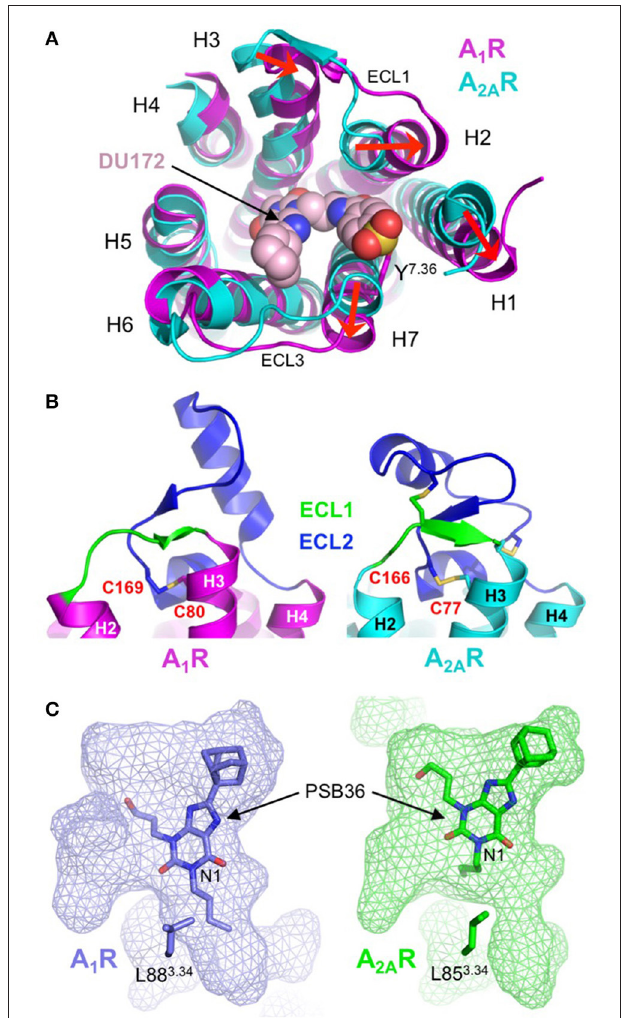
FIGURE 6 | Structural diversity of the adenosine receptor family. (A) Extracellular view of the conformational differences between DU172-bound A 1 R (colored magenta; PDB: 5UEN) (Glukhova et al., 2017) and ZM241385-bound A 2A R (colored cyan; PDB: 4EIY) (Liu et al., 2012). The extracellular ends of H1, H2 and H7 are displaced outwards by 5, 4, and 4 Å, respectively and H3 is displaced inwards by 4 Å (indicated by red arrows). The antagonist DU172 (shown as spheres) is covalently attached to Y271 7.36 (shown as sticks) through a benzene sulfonate linkage. Note that for clarity, ECL2 has been omitted from the alignment. (B) Differential conformations of ECL1 (colored green) and ECL2 (colored blue) in A 1 R (colored magenta; PDB: 5UEN) (Glukhova et al., 2017) and A 2A R (colored cyan; PDB: 4EIY) (Liu et al., 2012), disulphide bonds are shown as sticks. In A 1 R ECL2 adopts an extended conformation that is stabilized by a single disulphide bond (C80 3.25 -C169 ECL2 ). In contrast, ECL2 from A 2A R adopts a compact conformation that is stabilized by three disulphide bond, one of which (C77 3.25 -C166 ECL2 ) is conserved in A 1 R. (C) Surface representation of the ligand-binding pocket (rendered as semi-transparent mesh) in A 1 R (colored blue; PDB: 5N2R) (Cheng et al., 2017) and A 2A R (colored green; PDB: 5N2S) (Cheng et al., 2017), which highlights differences in both the topology of the orthosteric site and the binding orientation of PSB36 (shown as sticks). The butyl substituent at position N1 of the xanthine core of PSB36 fits into a channel between H3, H5, and H6 in A 1 R, this channel is constricted in A 2A R due to the different orientation of L85 3.34 (shown as sticks), which results in the ligand binding in a different